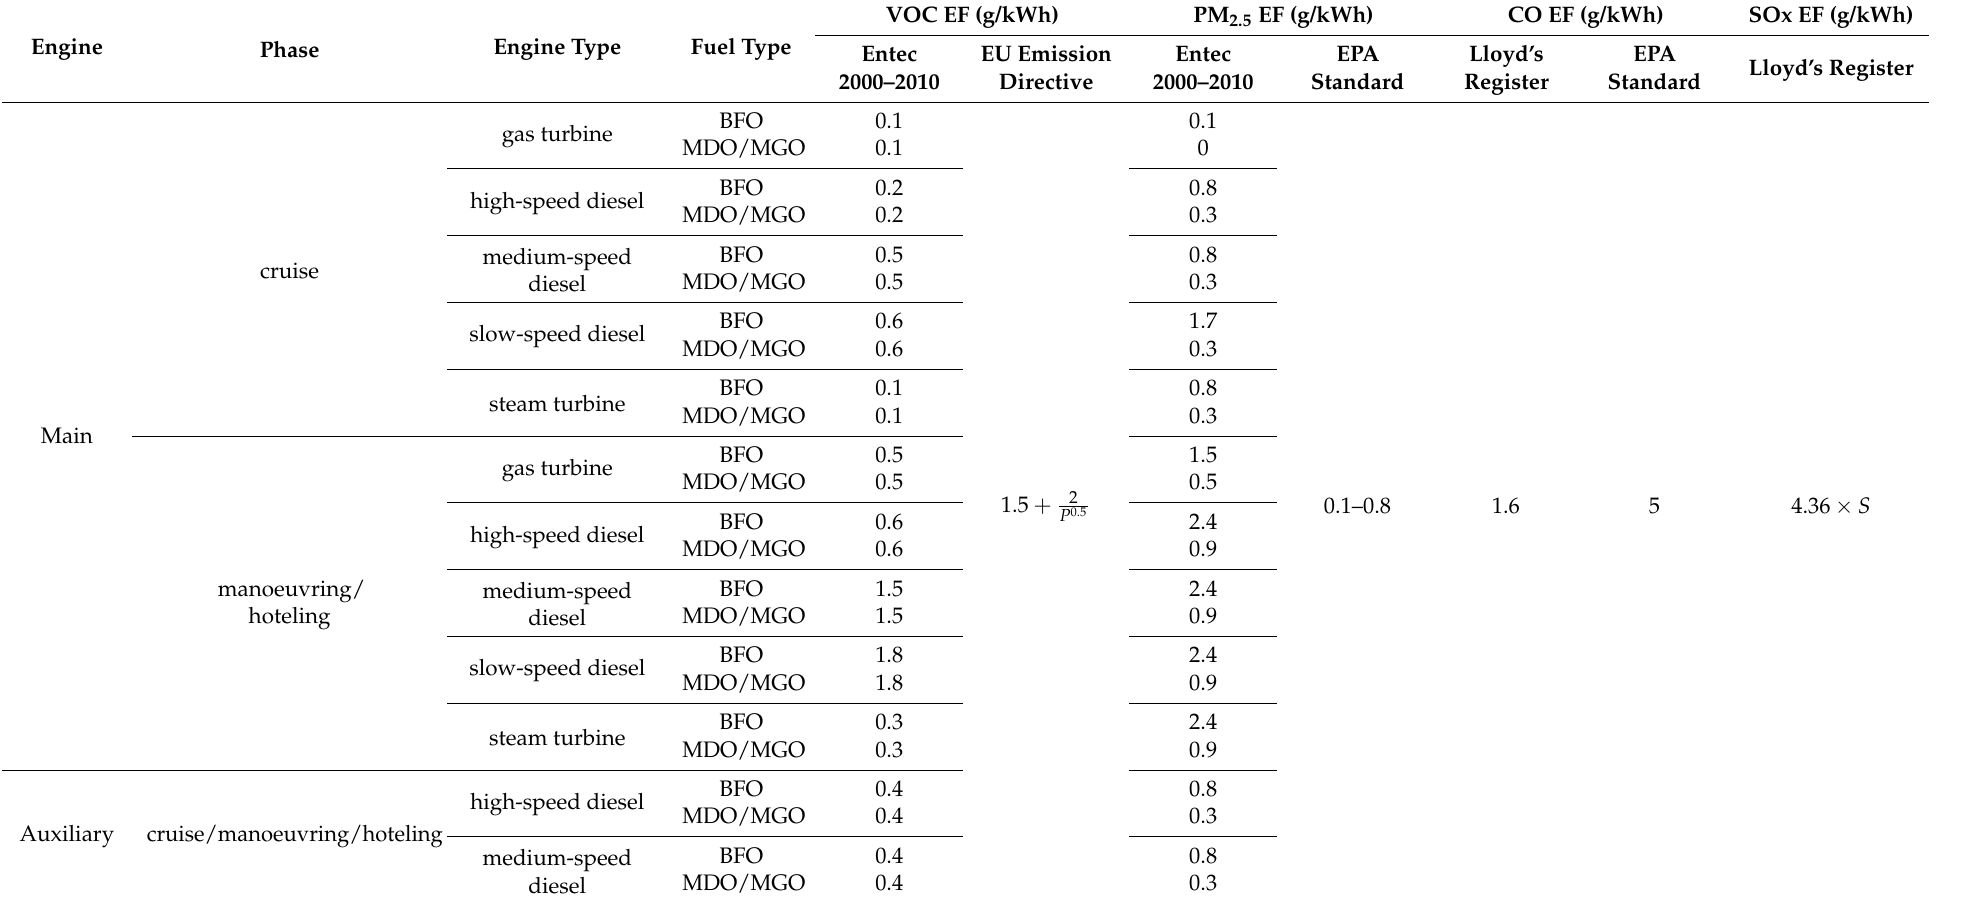
Table A3. Emission factors for VOC, PM 2.5 , CO and SOx. (P = engine power (kWh), S = percentage sulfur content in fuel (%))